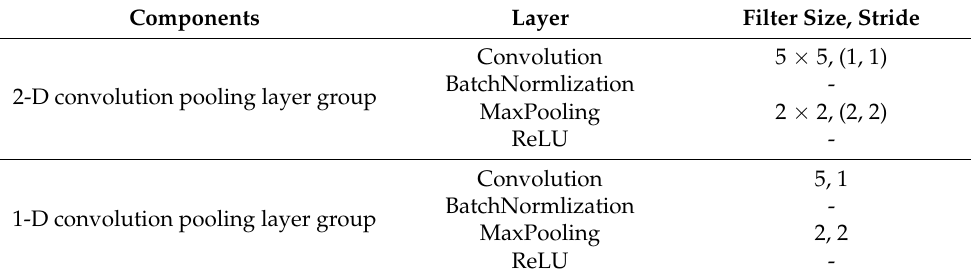
Table 3. Parameters of the convolution and pooling layer